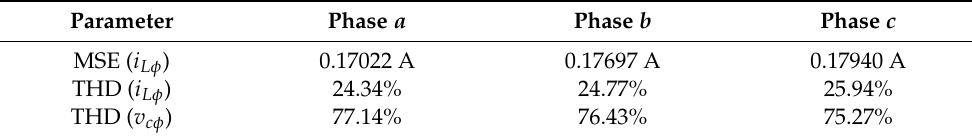
Figure 8. Experimental results for phase a in steady-state conditions. Table 5. Experimental results in steady-state conditions.